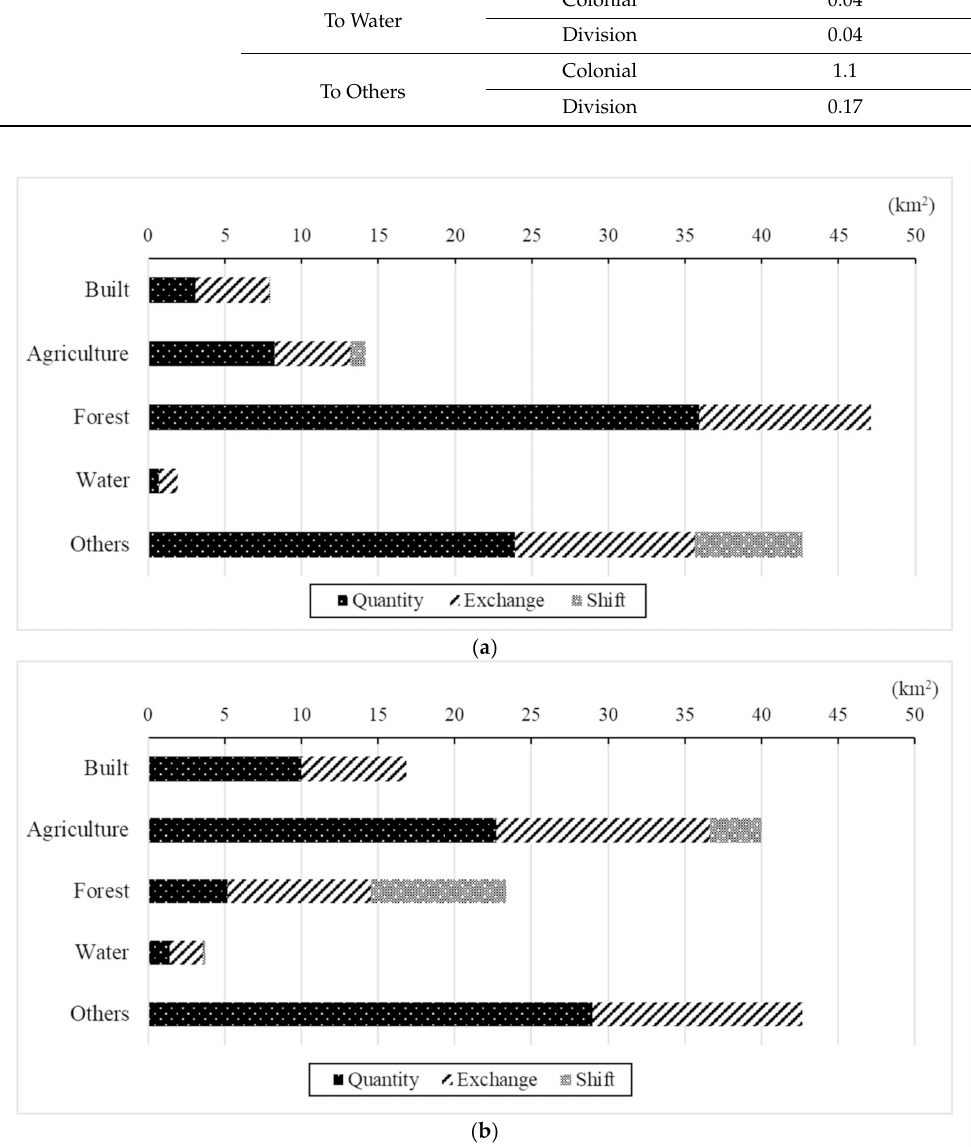
Figure 9. Category level change components in area during: ( a ) the colonial and ( b ) the division